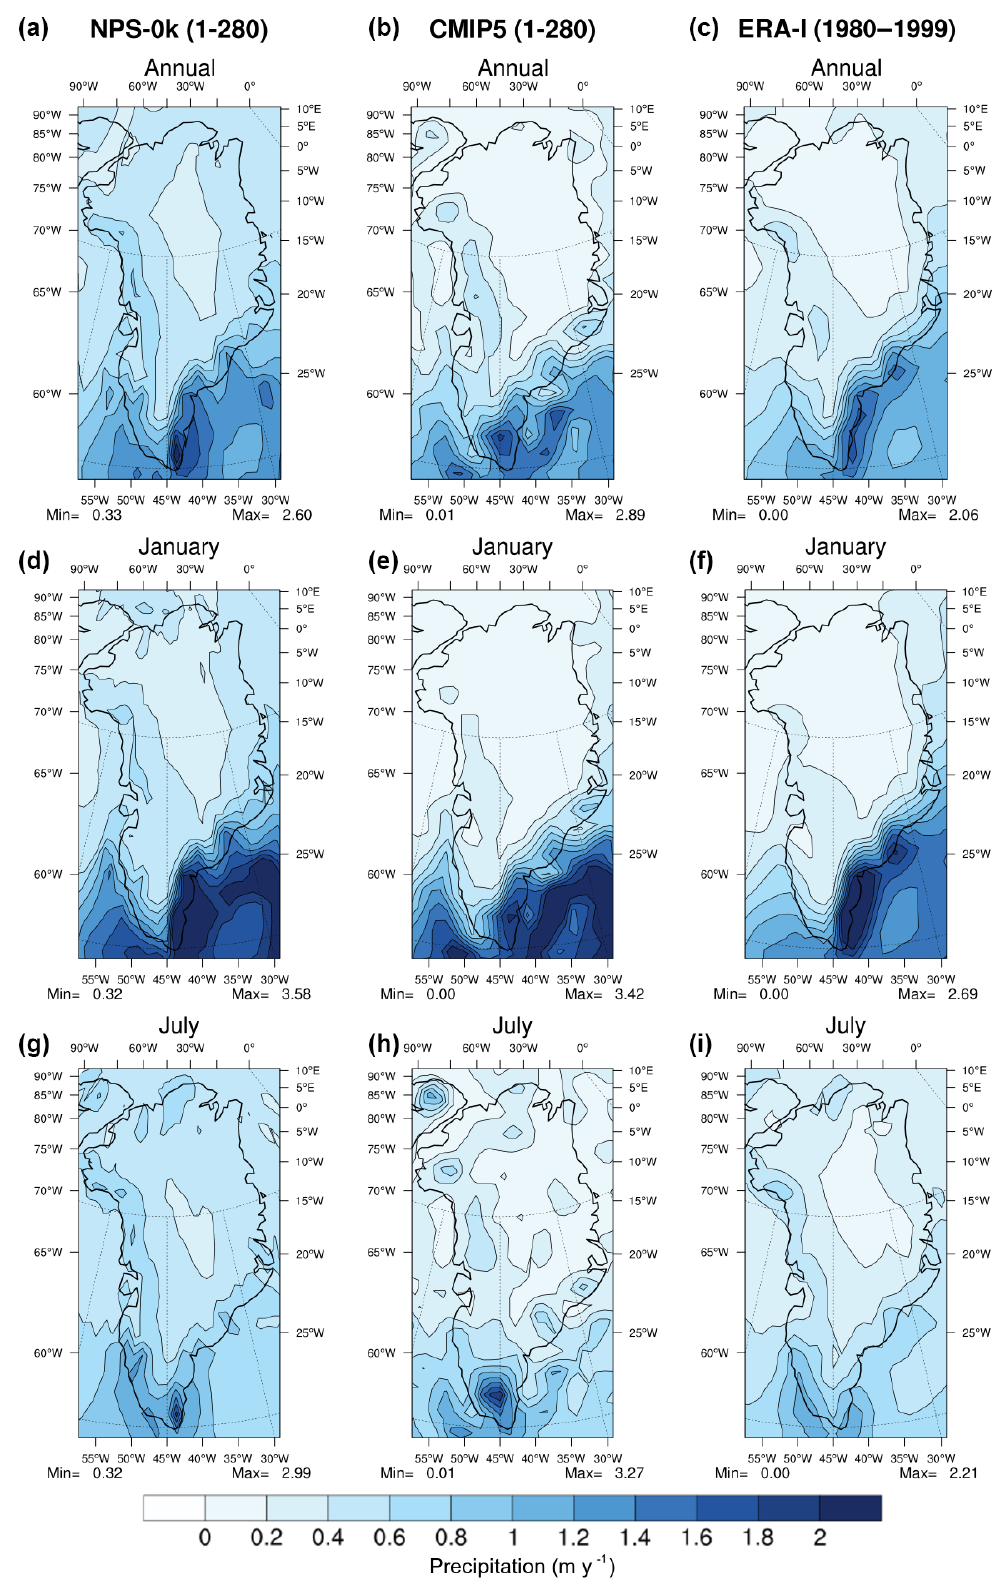
Figure 2. Annual mean precipitation (a, b, c) and monthly mean precipitation for January (d, e, f) and July (g, h, i) in the preindustrial simulations (years 1–280) NPS-0k (a, d, g) and CMIP5 (b, e, h) and ERA-Interim (1980–1999) (c, f, i)